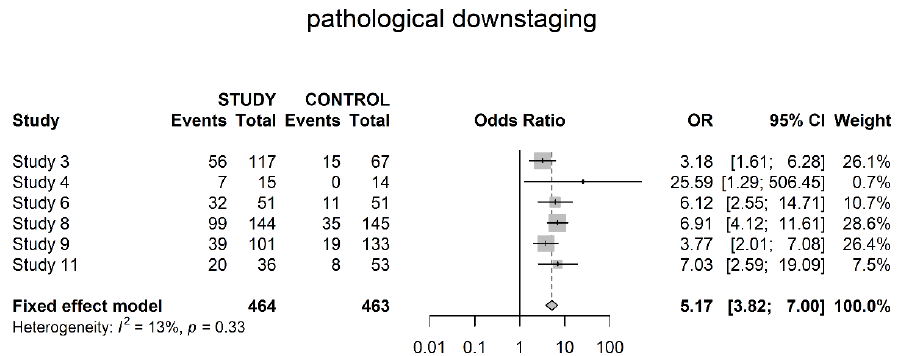
Figure 9. Overall pathological downstaging.